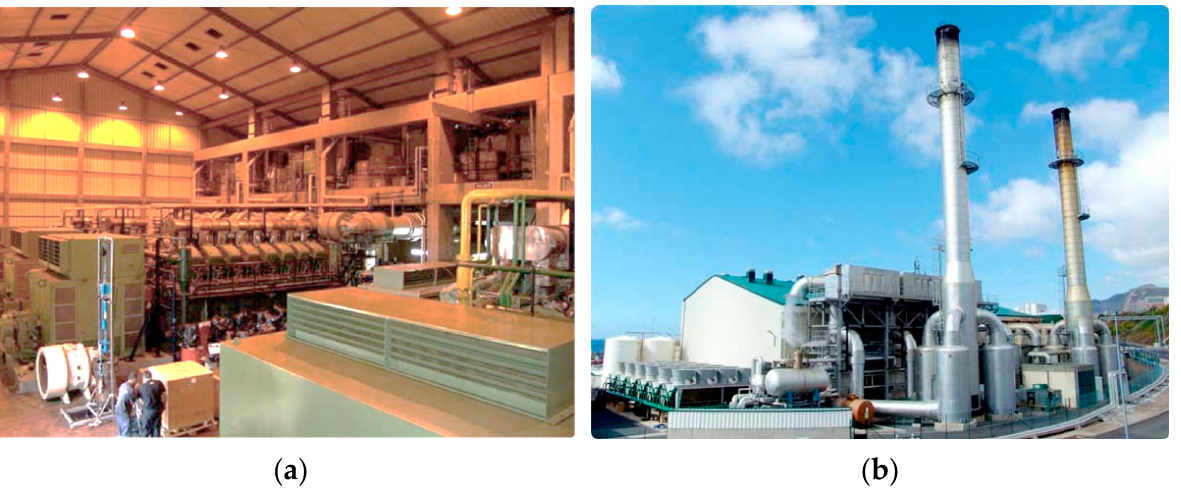
Figure 7. Thermoelectric power plant. ( a ) Sulzer combustion engines 16ZAV40S [16]; ( b ) Exhaust gases system and chimneys [52].